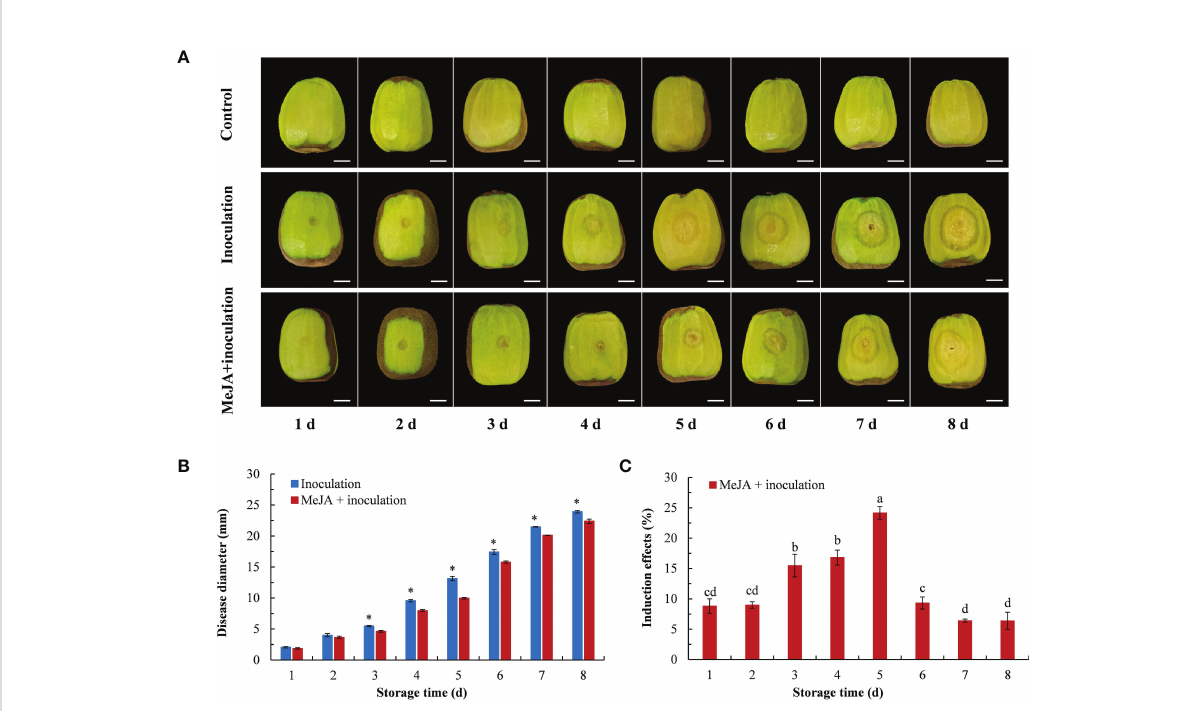
FIGURE 1 Effect of MeJA on diseases caused by B. dothidea in kiwifruit during storage time. (A) The symptoms of kiwifruits inoculated with B. dothidea in different treatment groups (Bar = 1 cm). (B) MeJA affects lesion diameter during storage time. (C) Induction effect of MeJA on kiwifruits. Bars shows standard deviation (SD, n=3). Letters and “ * ” indicate signi fi cant differences at P < 0.05 level among the